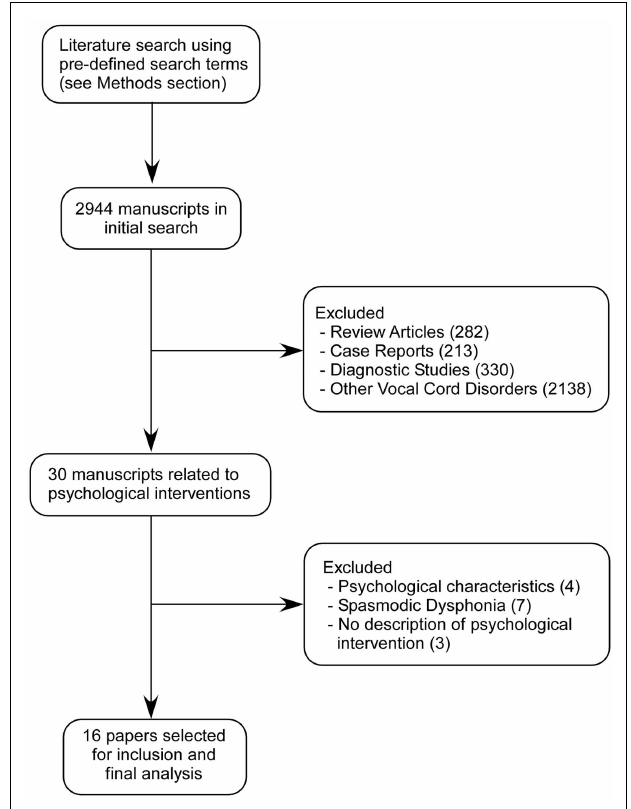
FIGURE 1 | Description of study selection process for systematic review